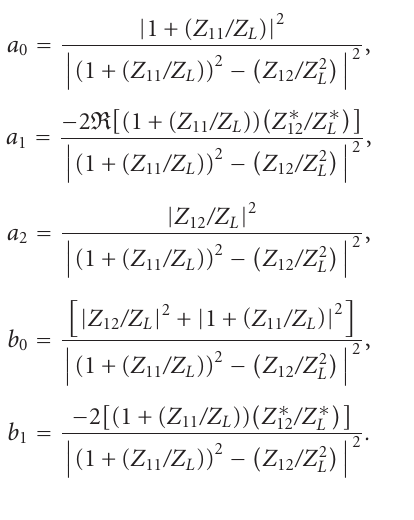
with complex antenna structures or irregular